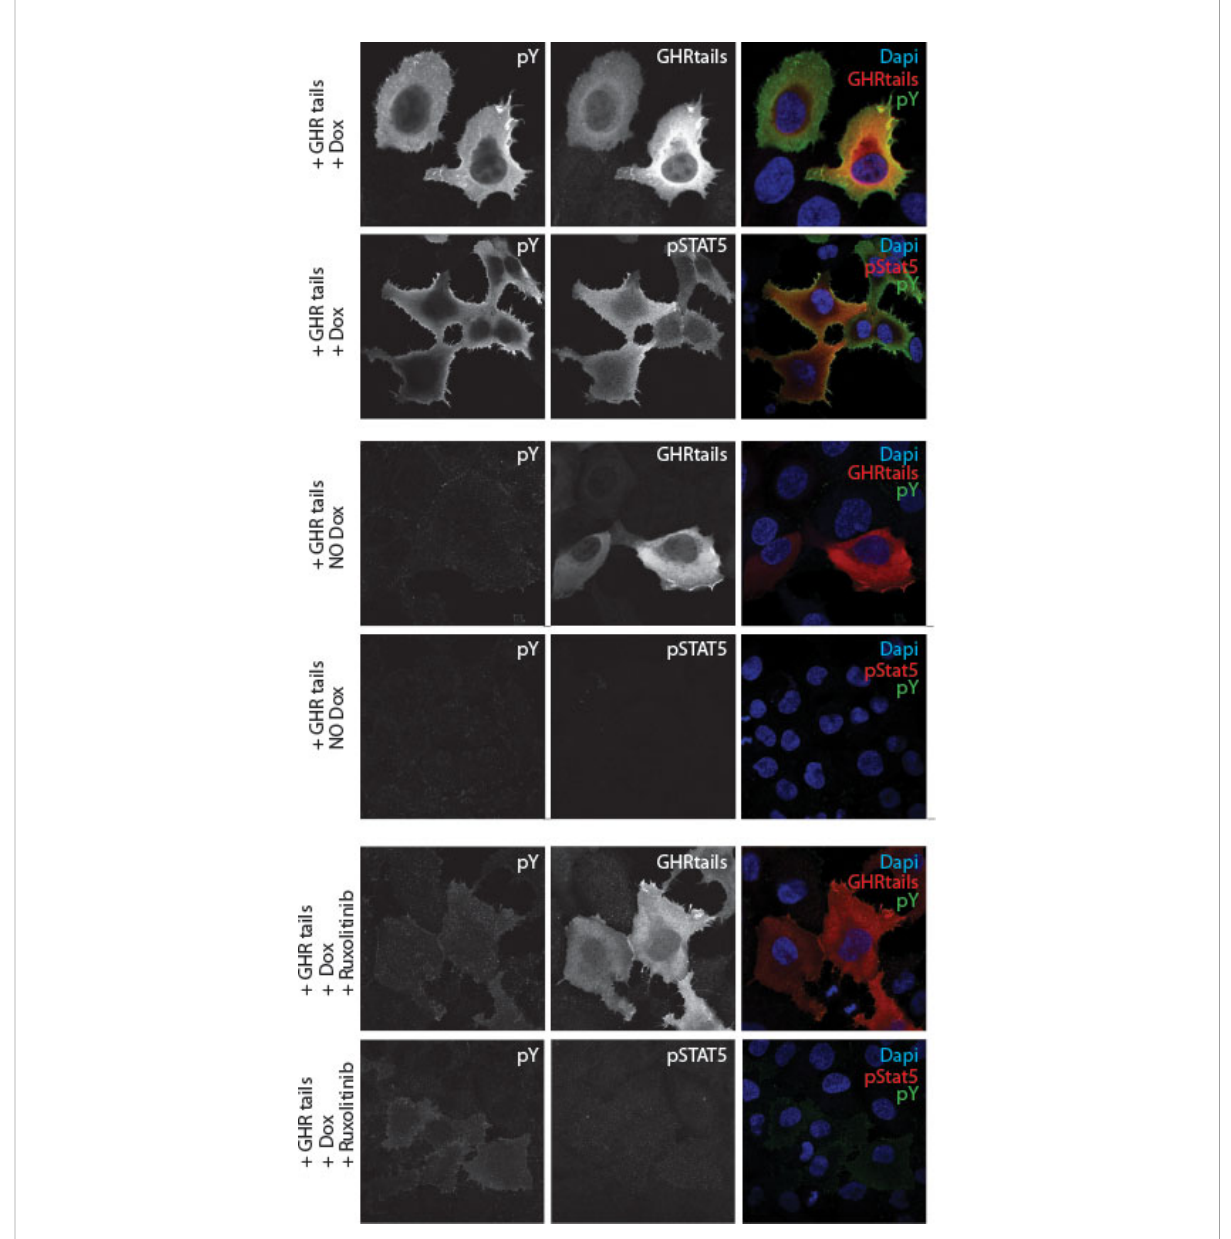
FIGURE 2 Immune fl uorescence staining of human y2a cell line stably transfected with an inducible Jak2 expression construct. Transient transfected zippered fos-GHRct accumulate only in the presence of Jak2 and induce phosphorylation of the tails, of Jak2, and STAT5 upon doxycycline- induction of Jak2